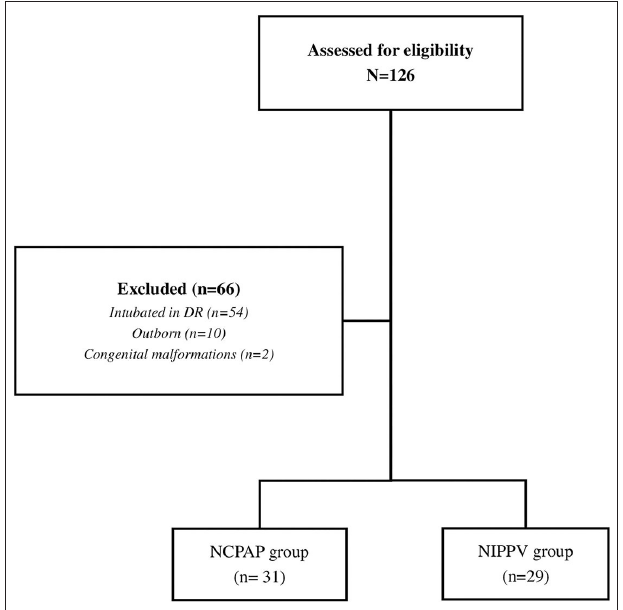
FIGURE 1 | Flowchart of the